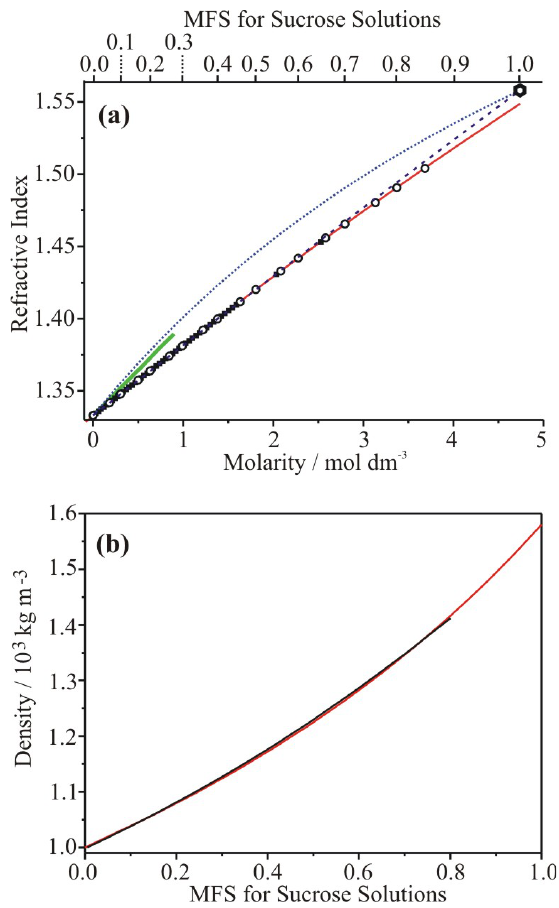
Fig. 1. (a) Refractive index as a function of the solute molarity and mass fraction of solute (MFS) for aqueous sucrose solutions: black squares, these measurements; open circles, literature data; red line, polynomial fit; dashed blue line, volume fraction mixing rule; dot- ted blue line, mass fraction mixing rule; hexagon, value taken as crystalline refractive index from Halbout and Tang (1982). A pa- rameterised fit to the measured values for aqueous raffinose solu- tion are shown by the green line. (b) Dependence of sucrose solu- tion density on solute molarity: black line, literature data (Haynes, 2011); red line, volume additivity